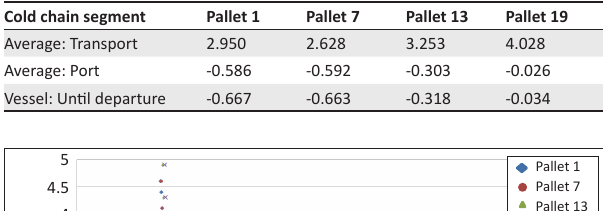
TABLE 3: Average temperature during different segments of the cold chain ( ° C ).